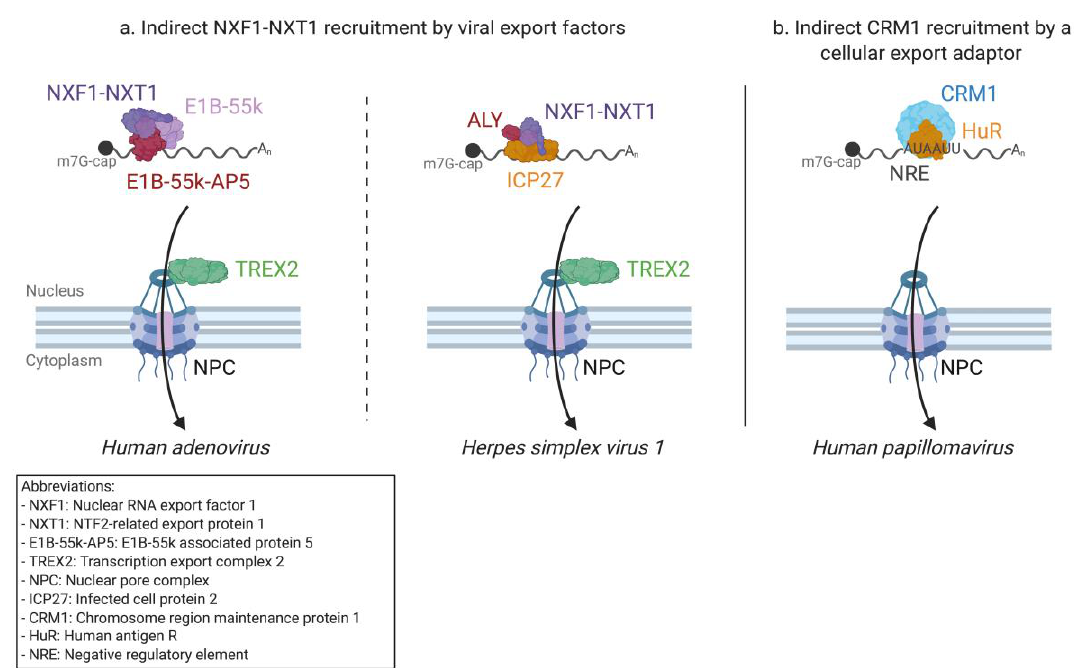
Figure 4. Examples of the mRNA nuclear export of DNA viruses. ( a ) Both Adenoviruses and Herpesviruses recruit NXF1–NXT1 exportins to their mRNAs indirectly through viral adapter proteins. The Adenovirus early protein E1B-55k and its associated cellular partner, E1B-55k-AP5, bind to viral mRNAs and recruit NXF1–NXT1 which promotes nuclear export of the mRNP complex through the TREX2 NPC interaction mechanism. Herpes simplex virus 1 codes the ICP27 export protein, which is well conserved within Herpesviridae . ICP27 recruits NXF1–NXT1 export receptors through the cellular ALY protein, inducing transport through the NPC by interacting with the TREX2 complex. ( b ) Human Papillomavirus late mRNAs presumably recruit cellular CRM1 through the cellular adapter protein HuR, which binds to the negative regulatory element (NRE) RNA element.